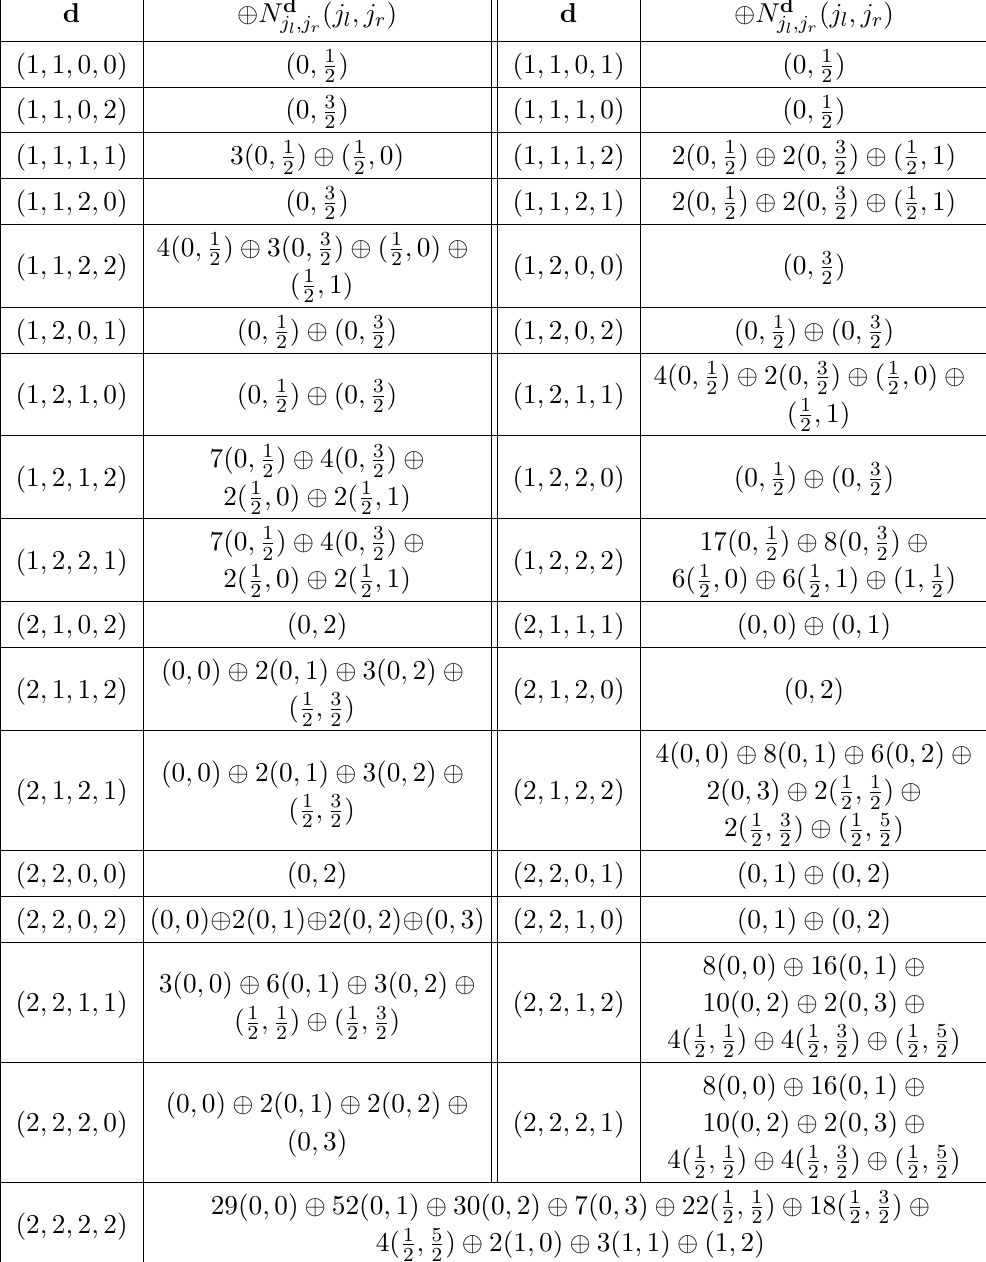
Table 19 . Spectrum of the Wilson loop operator in the representation r = [ − 1 , 0 , 0] in the 6d minimal SU(3) theory for d i ≤ 2 . Here, d = ( d 1 , d 2 , d 3 , d 4 ) labels the BPS states with fugacity Q − 1 / 3 Q 1 / 3 Q 1 / 3 1 3